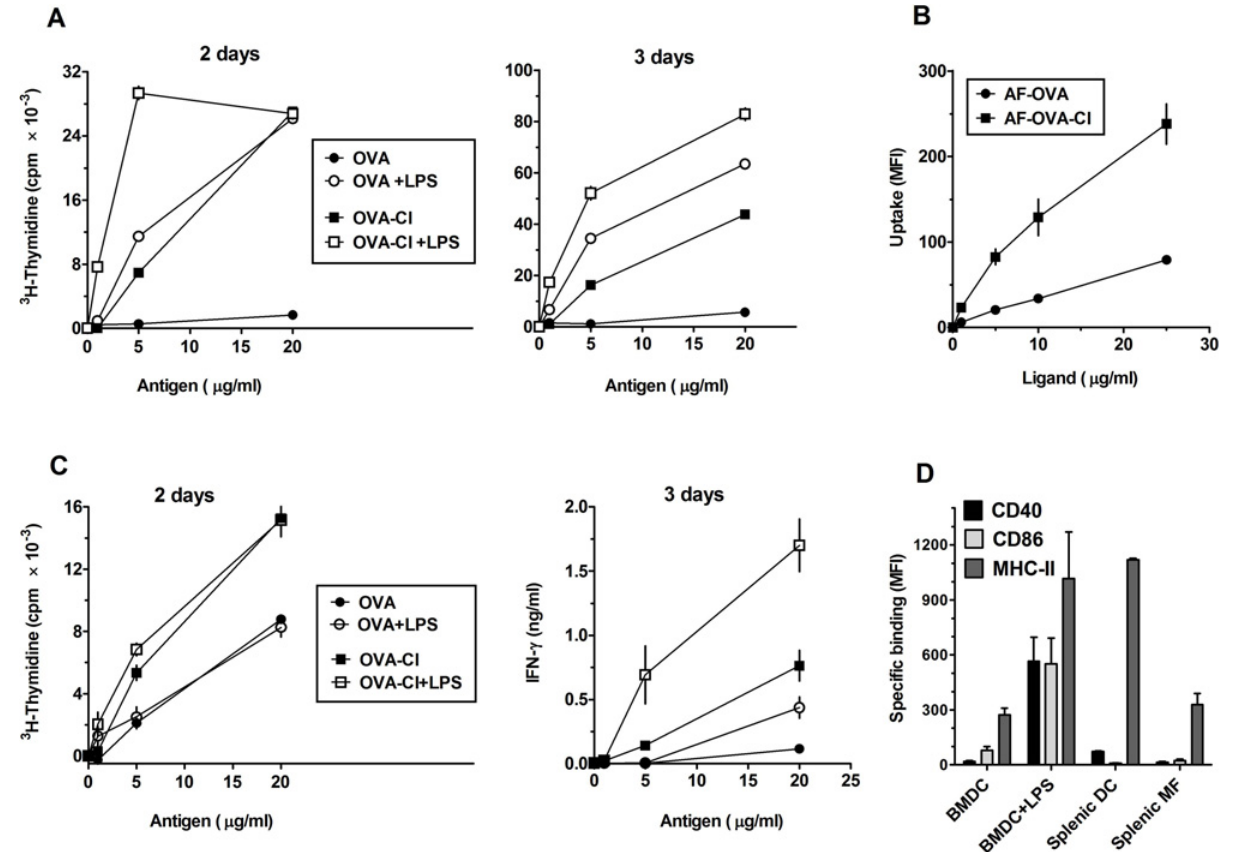
Fig 1. OVA-Cl exhibits increased immunogenicity that may be caused by enhanced uptake by APC. ( A ) BM-DC were incubated with indicated concentrations of OVA or OVA-Cl for 2 h at 37°C. When indicated, 200 ng/ml LPS was additionally included. Following washing, 0.4 × 10 5 BM-DC were co- cultured for 2 or 3 days with 1.5 × 10 5 CD4 + OT-II lymphocytes. One μ Ci of 3 H-thymidine was added for the last 20 h of co-culture and radioactivity incorporated by proliferating lymphocytes was measured by scintillation counting. ( B ) BM-DC were incubated for 1 h at 37°C with indicated concentrations of Alexa Fluor 647-labelled OVA (AF-OVA) or OVA-Cl (AF-OVA-Cl) and, following washing, cell-associated fluorescence was measured by flow cytometry. ( C ) Unfractionated splenocytes, prepared from spleens of OT-II mice, we pre-incubated with OVA, OVA-Cl and LPS, as described in A, washed, plated